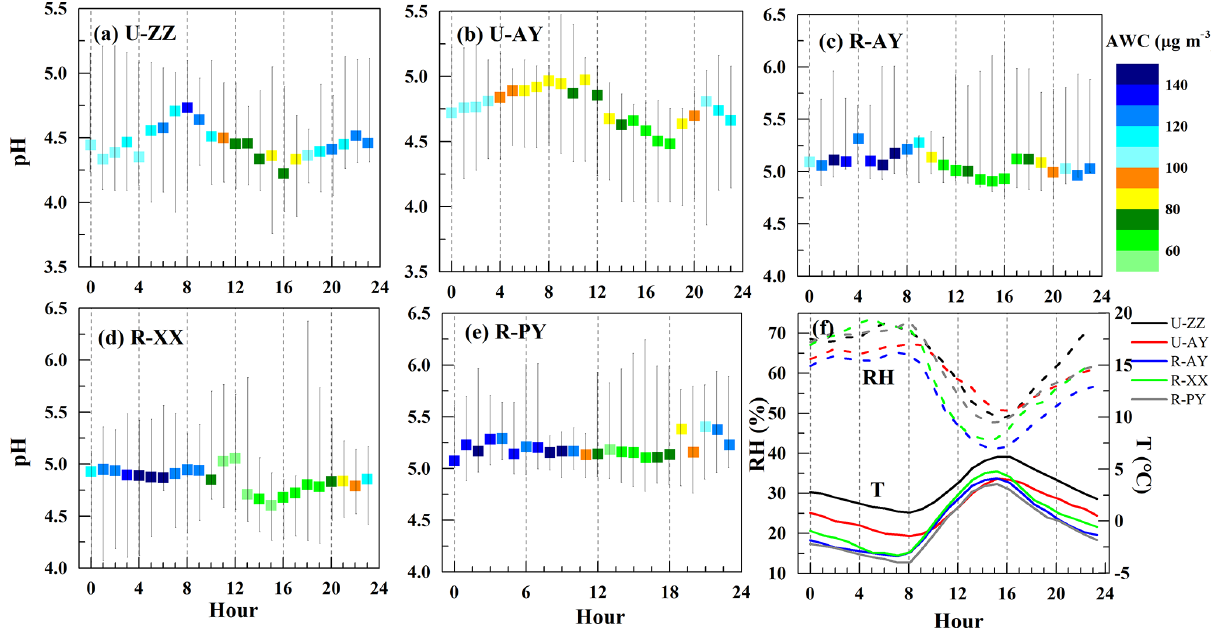
Figure 4. (a–e) Diurnal patterns of median pH values, (f) average RH, and T of the five sites in Case 2. The upper and lower ends of the line represent the maximum and minimum values of pH, respectively. The color scale bar represents AWC